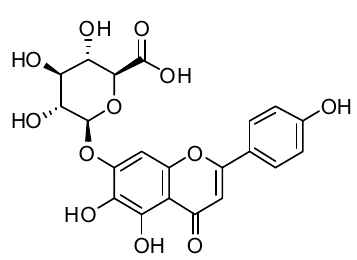
Figure 1. Structure of